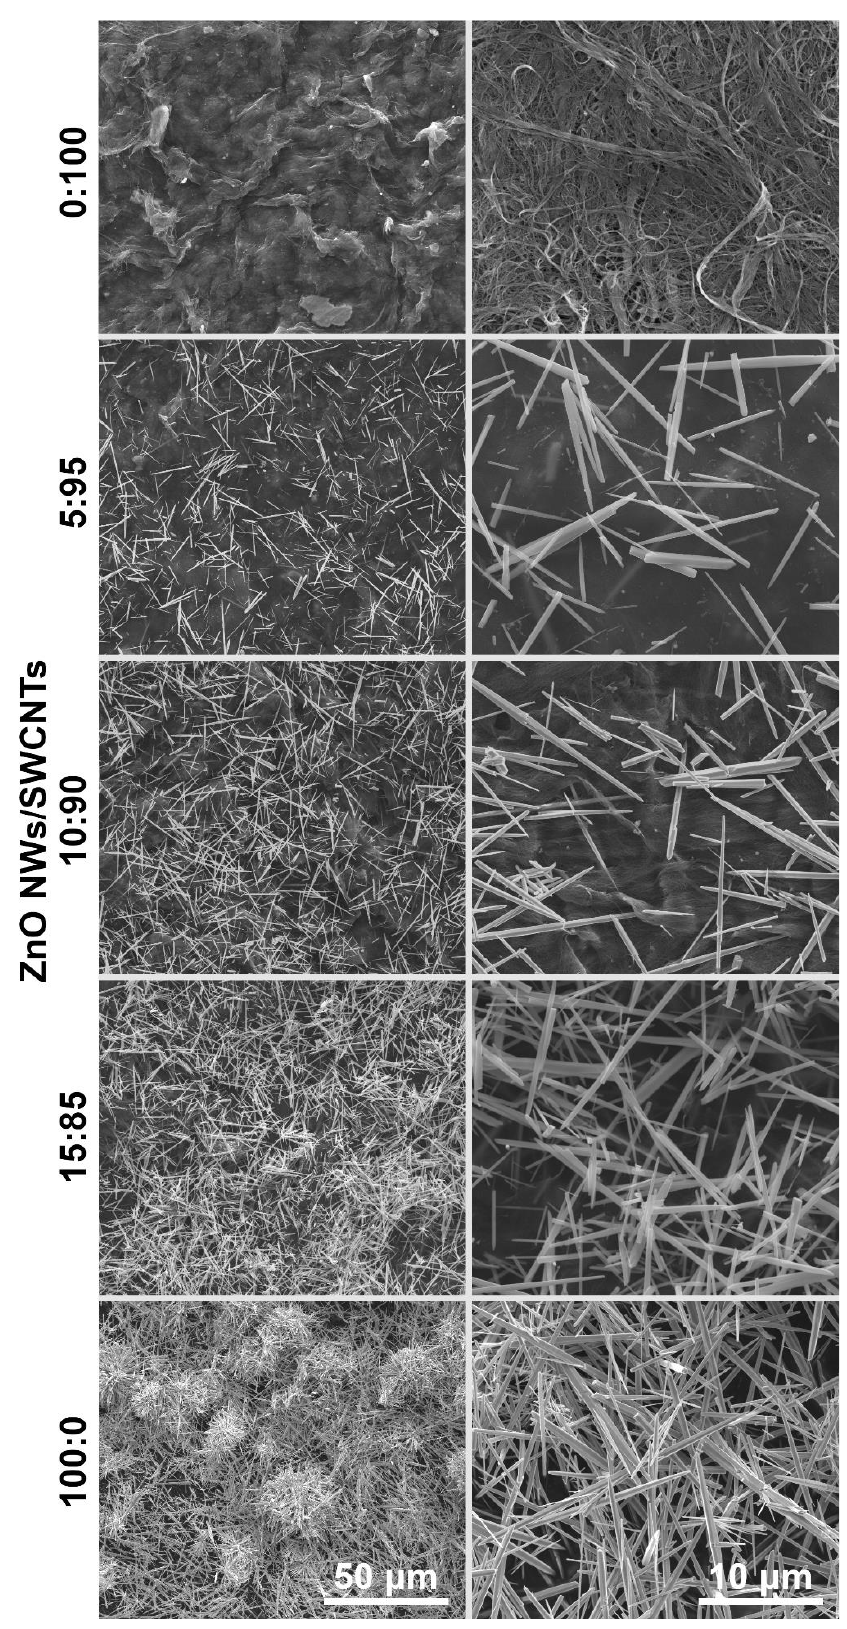
Figure 3. SEM micrographs of an SWCNT film, SWCNT films filled with ZnO NWs — 5%/10%/15% by weight, and ZnO NWs.